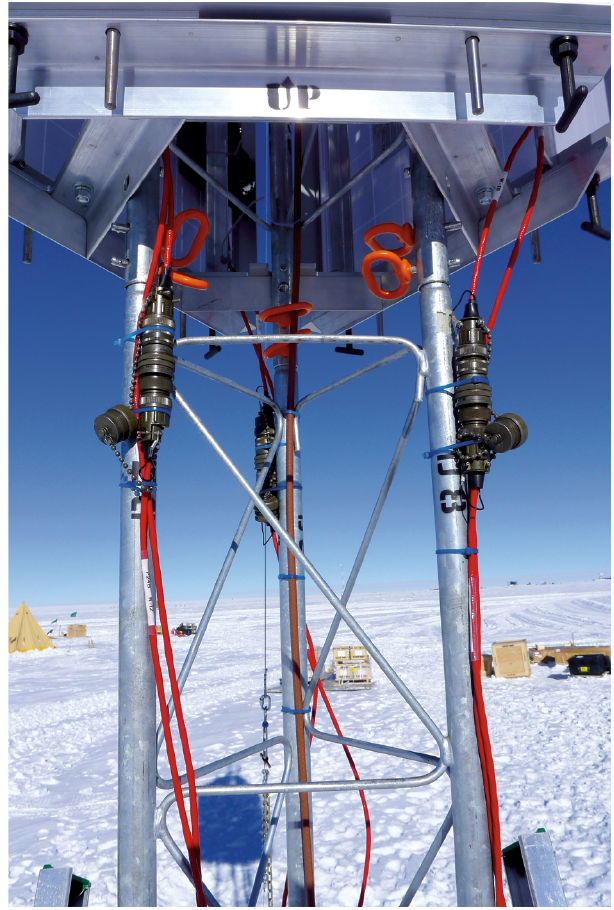
Figure 3. Tower close-up view showing orange pins used to secure tower sections and T-bolts at top securing the bottom of the PV panels.